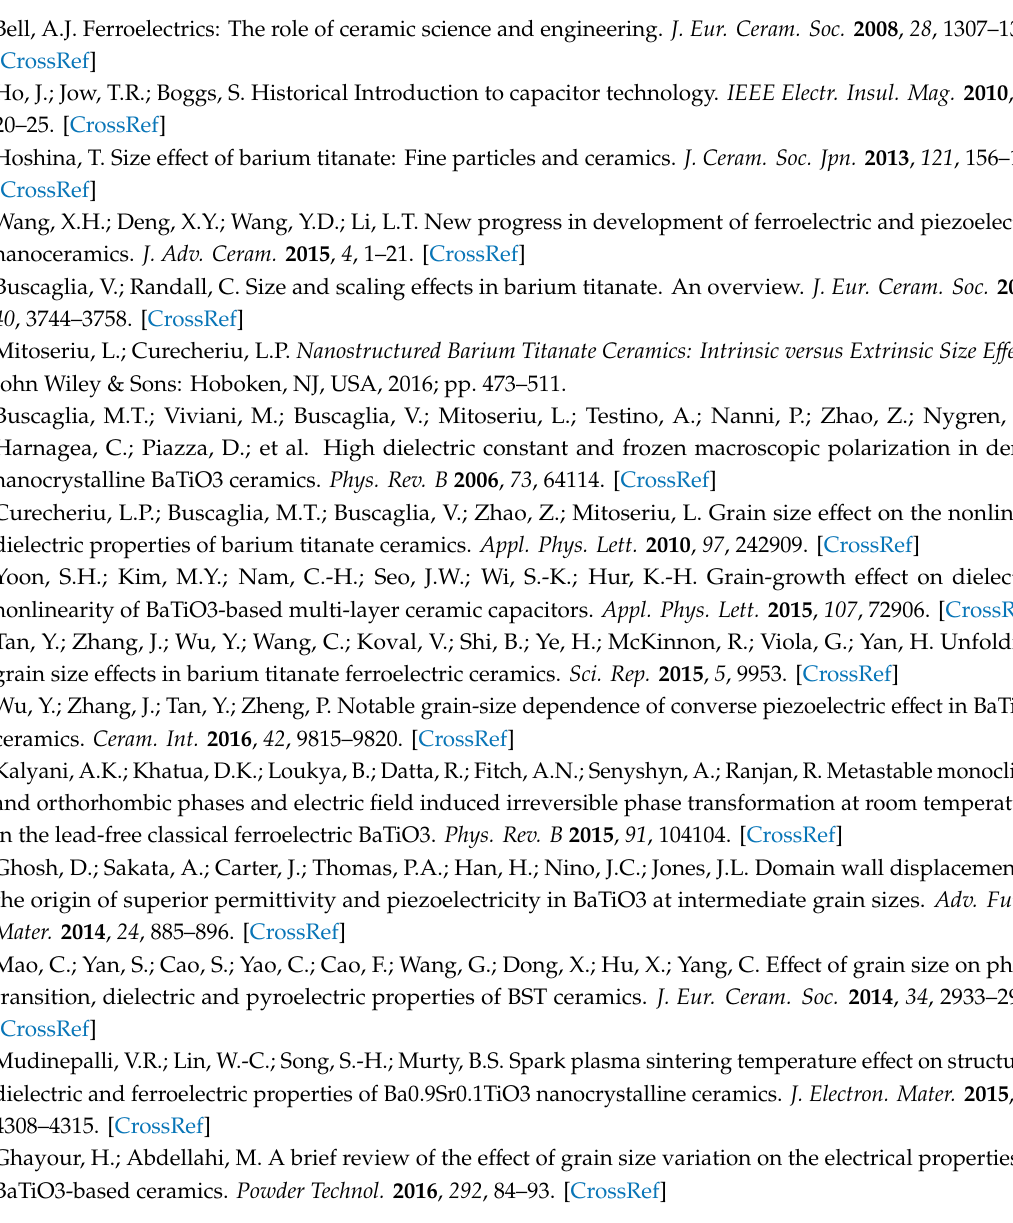
by FEM for the dense system (a). The local field images (d–f) are represented in color scale and the black lines are isopotential, Figure S6: Local electric field distributions on grain bulk (a) and on the pore (b) calculated for di ff erent GSs, Figure S7: Simulated dependences of the e ff ective permittivity vs. grain size for the 3 types of systems: the dense system (black curve), the tri-phase porous system (red curve) and the di-phase equivalent porous system (blue curve) in which the e ff ective permittivity calculated for the dense structure was introduced as input as the permittivity of the dense